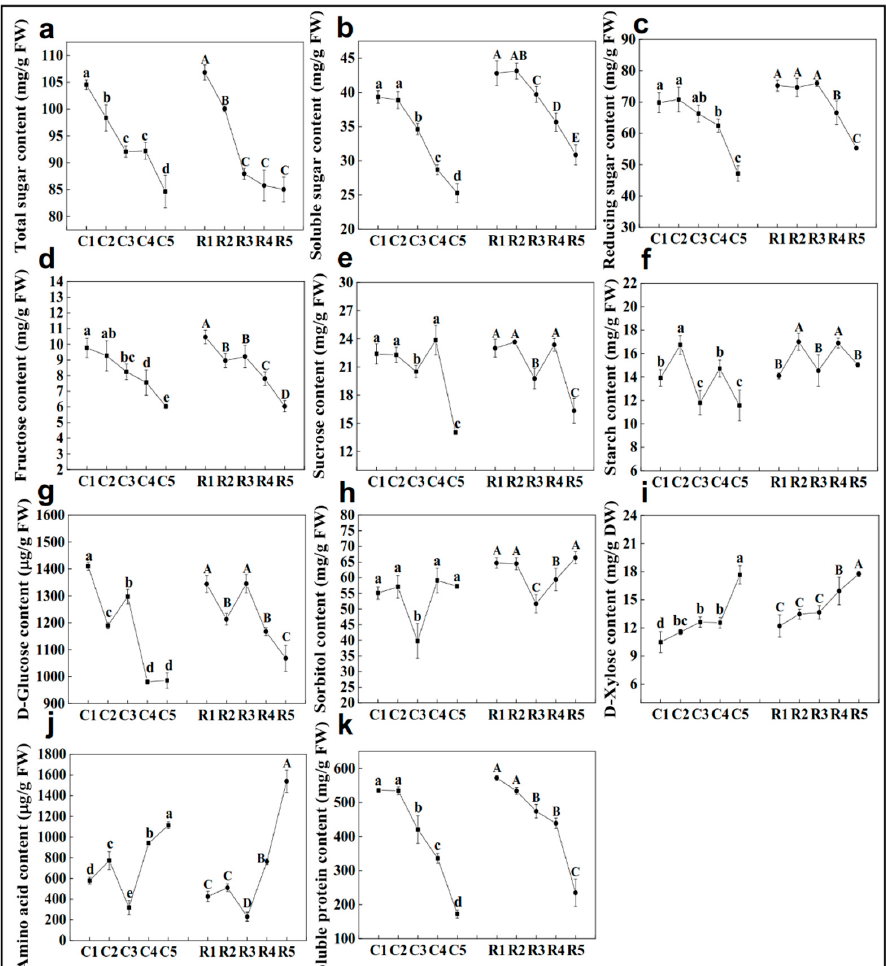
Figure 5. Changes of total sugar ( a ), soluble sugar ( b ), reducing sugar ( c ), fructose ( d ), sucrose ( e ), starch ( f ), D-glucose ( g ), sorbitol ( h ), D-xylose ( i ), amino acid ( j ), and soluble protein ( k ) concentrations during flower bud differentiation of Chinese cherries. C1–C5 represent the five stages of shelter-free cultivation, R1–R5 represent the five stages of rain-sheltered cultivation. Data are presented as the mean ± SD of three biological replicates. Different capital letters on the dots indicate significant differences between different stages of rain-sheltered model at p < 0.05 determined by Duncan’s tests, lowercase letters indicate significant differences of shelter-free